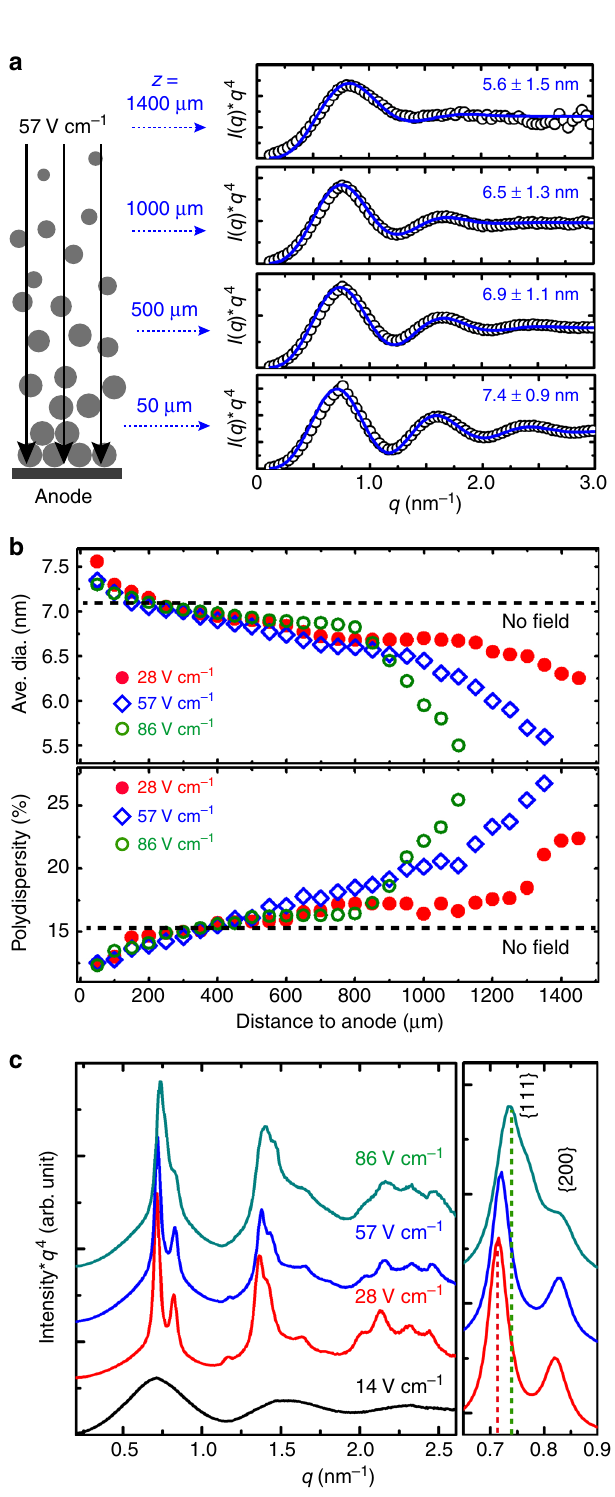
constants for weaker fi elds (Fig. 6a). The dependence of lattice constant on applied fi eld strength of solvated and dried super- lattices is summarized in Fig. 6b. The superlattice volume contracts by ~35% during drying.